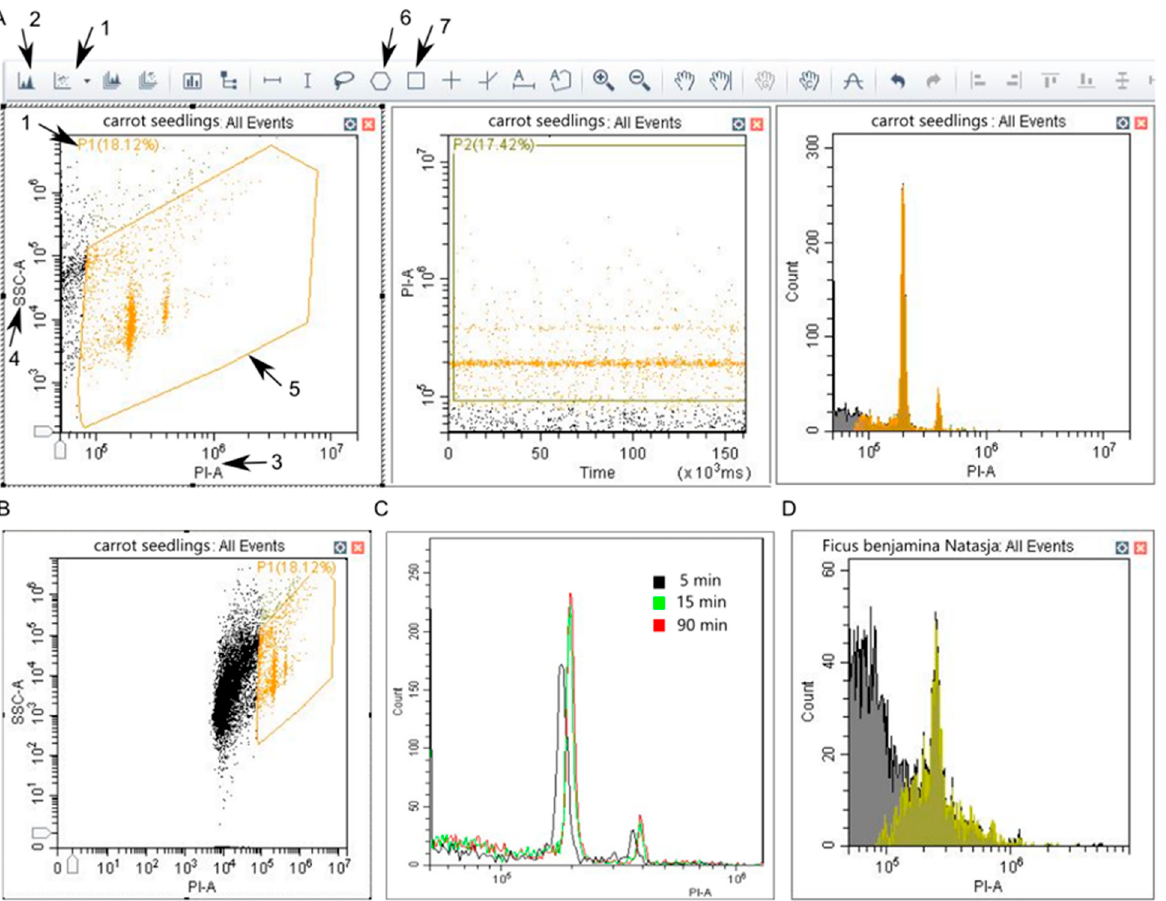
Figure 1. Flow cytometer acquisition settings for DNA content analysis. ( A ). Create two dot plots and a histogram by pressing (1) and (2), respectively. Adjust axes by pressing on them and selecting PI-A (3) and SSC-A (4). Change axes to Time and PI-A for the second plot. Select PI-A for X axis of the histogram. The population of interest (5) can be selected by polygonal (6) and rectangular (7) tool. ( B ). Cytometric data before adjusting plot properties. A large population of debris is observed. The target population (P1) makes up less than 20% of recorded particles. ( C ). Carrot seedling nuclei stained with PI for 5 (black), 15 (green) and 90 (red) minutes. ( D ). Example of poor isolation of nuclei. Nuclei are partially masked by excessive debris population.